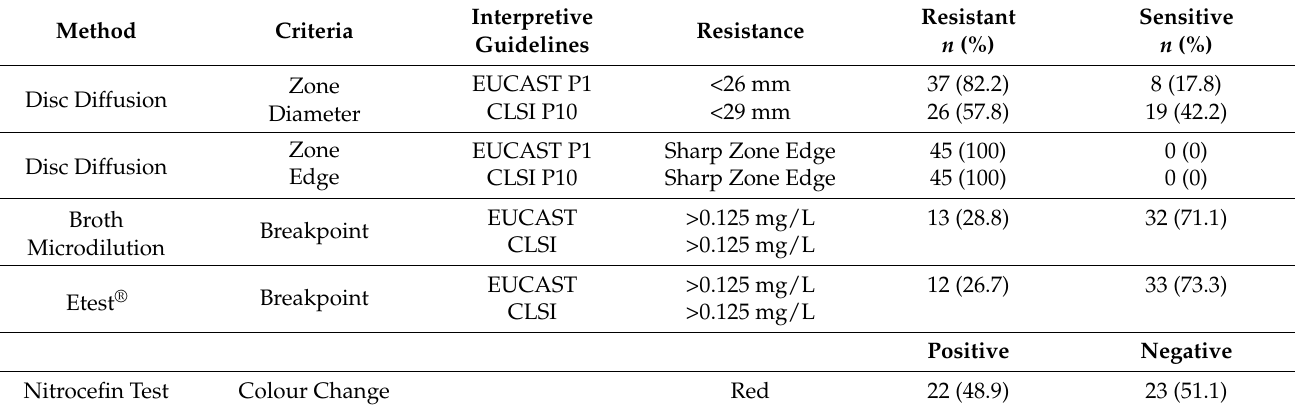
Table 3. Penicillin susceptibility and nitrocefin results of 45 blaZ -positive Vitek ® 2 penicillin- susceptible S. aureus